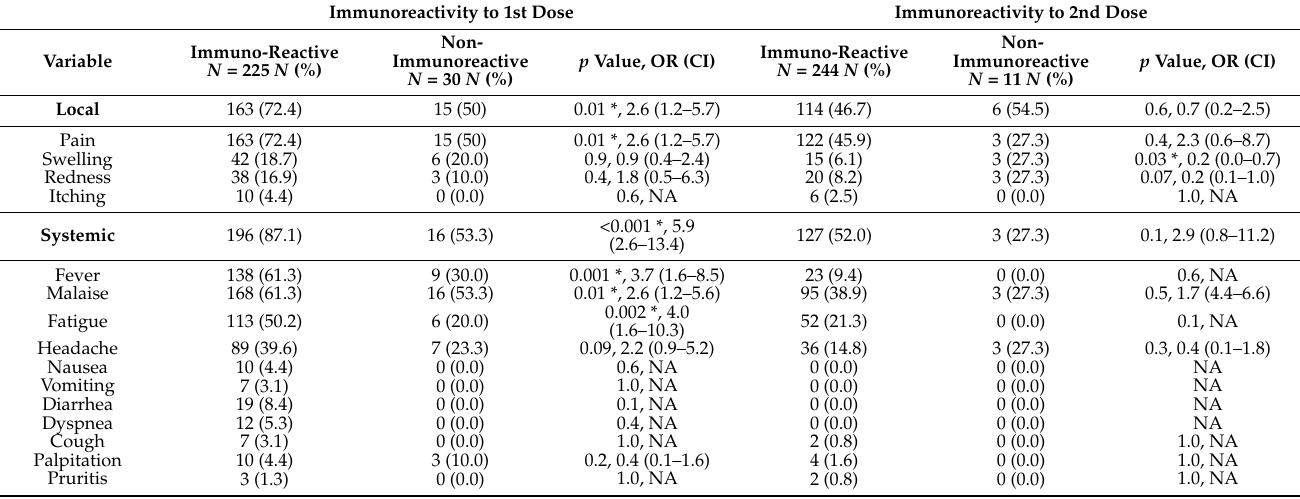
Table 5. Relation between adverse reactions and immunoreactivity to